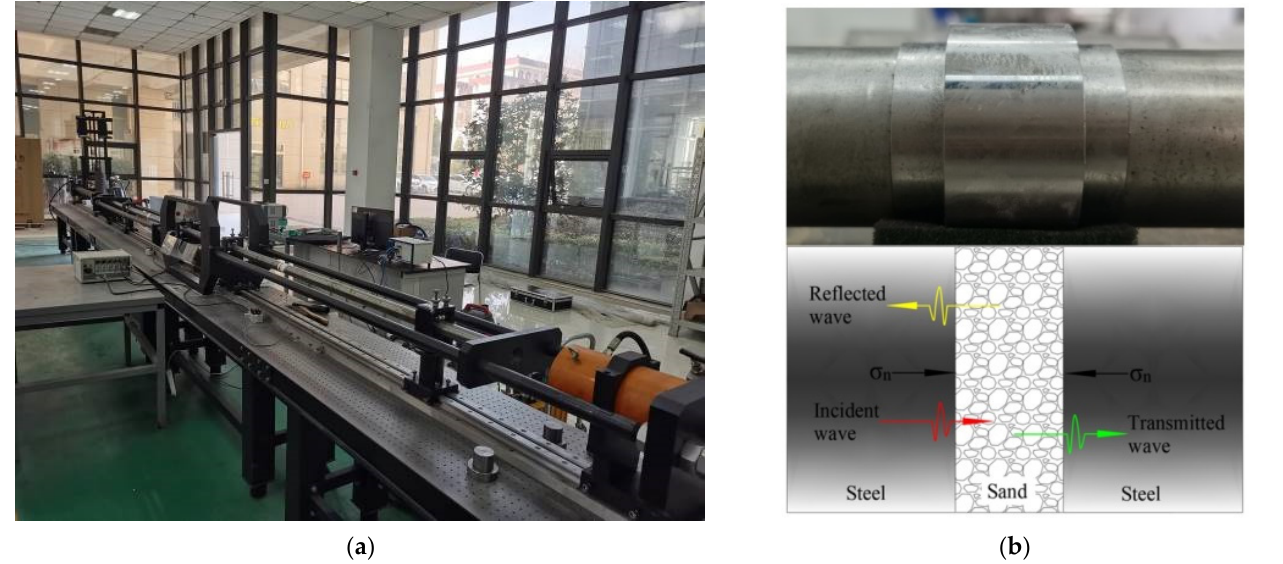
Figure 2. ( a ) Experimental setup. ( b ) Schematic of steel specimen confinement chamber and wave propagation in the system.